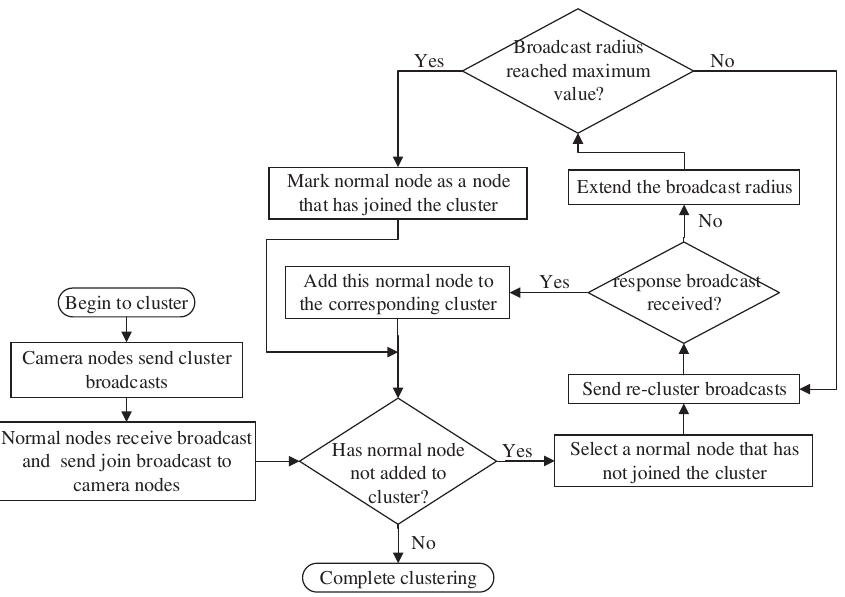
Figure 3. The flowchart of the camera node-normal node cluster establishment